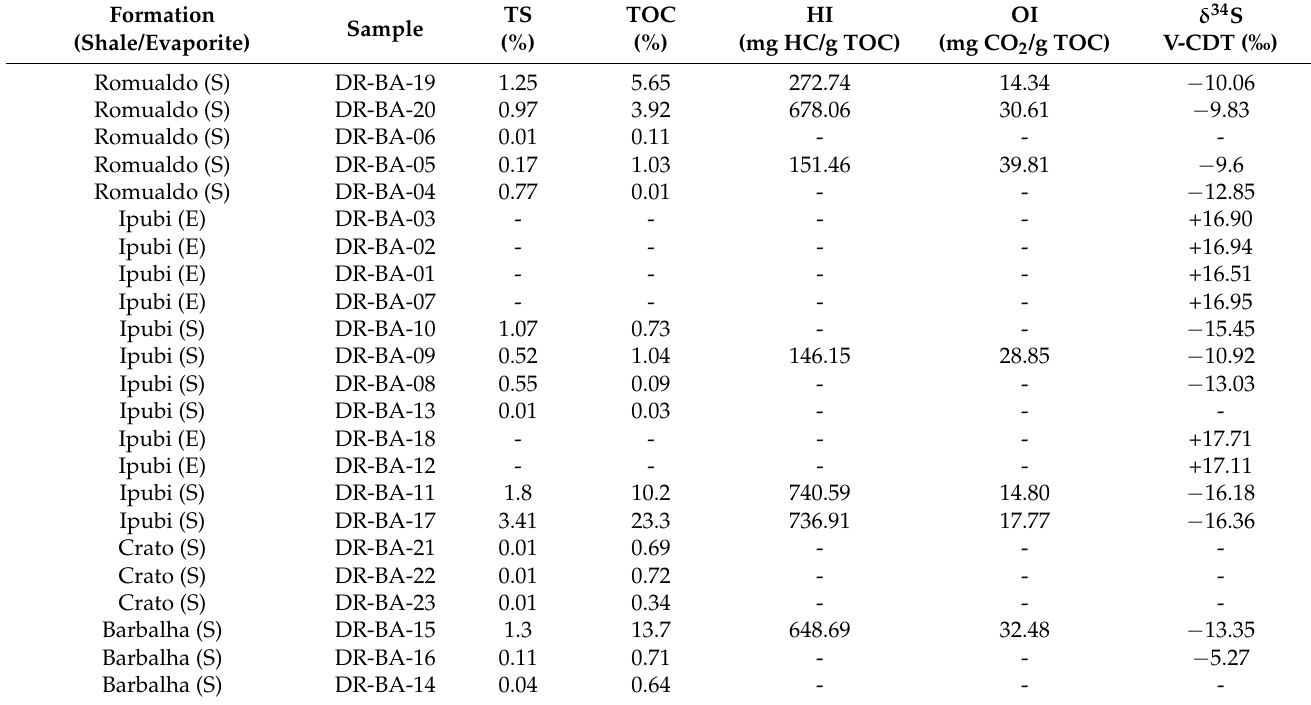
Table 1. Total sulfur (TS), total organic carbon (TOC), hydrogen index (HI), oxygen index (OI), and sulfur isotopic ( δ 34 S) values obtained for the investigated lithotypes. The vertical stacking is in agree with the stratigraphic positioning of the collected